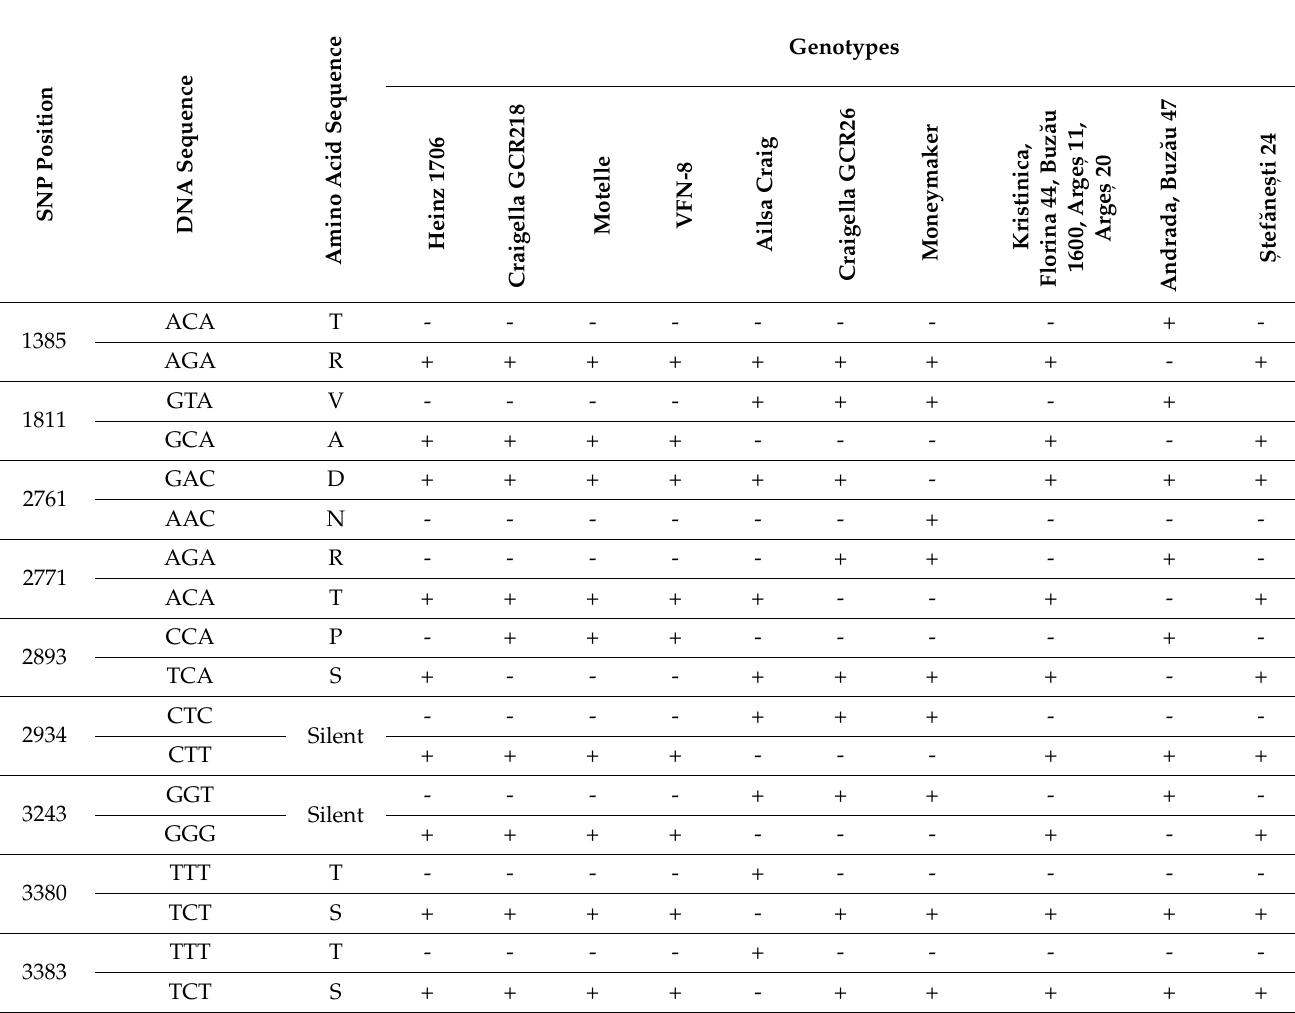
Table 2. Sequence analysis of the Ve2